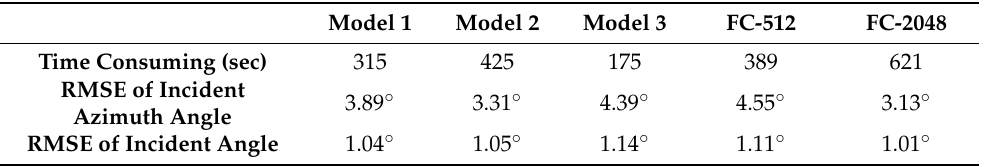
Table 3. Performance of 100 realizations of the dataset at 13.9 GHz, 5.5 m/s using the CNN methods illustrated in Table 2. The numbers reported in this table are the average of all